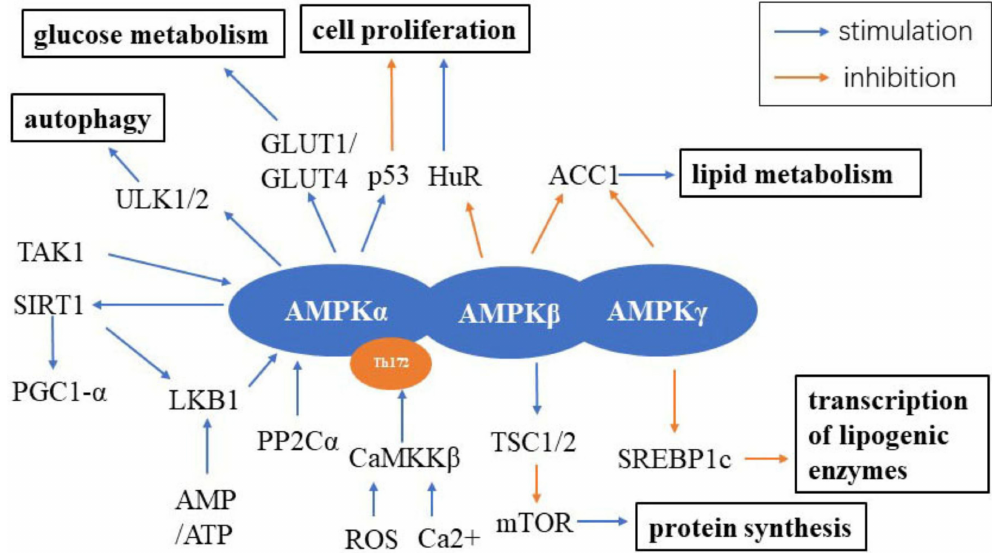
Figure 1. AMPK signaling in the cell. AMPK is composed of three subunits: the catalytic α subunit and regulatory β and γ subunits. The upstream of AMPK includes LKB1, CaMKK β , TAK1 and PP2C α , while the downstream pathways controlled by AMPK include ULK1/2, SIRT1, TSC1/2, SREBP1c, ACC1, HuR, p53 and GLUT1/GLUT4. Abbreviations: AMPK: adenosine onophosphate-activated kinase; LKB1: liver kinase B1; CaMKK β : Ca 2+ /calmodulin-dependent protein kinase kinase β ; TAK1: transforming growth factor β -activated kinase 1; PP2C α : protein phosphatase 2C α ; ACC1: aminocyclopropane-1-carboxylic acid; GLUT1: glucose transporter 1; GLUT4: glucose transporter 4; ULK1/2: autophagy activating kinase 1/2; PGC1- α : peroxisome proliferator-activated receptor gamma coactivator-1 α ; ROS: reactive oxygen species; SIRT1: Sirtuin 1; AMP: adenosine monophosphate; ATP: adenosine triphosphate; TSC1/2: tuberous sclerosis complex 1/2 protein; mTOR: the mammalian target of rapamycin; SREBP1c: sterol regulatory element binding protein 1c; HuR: human antigen